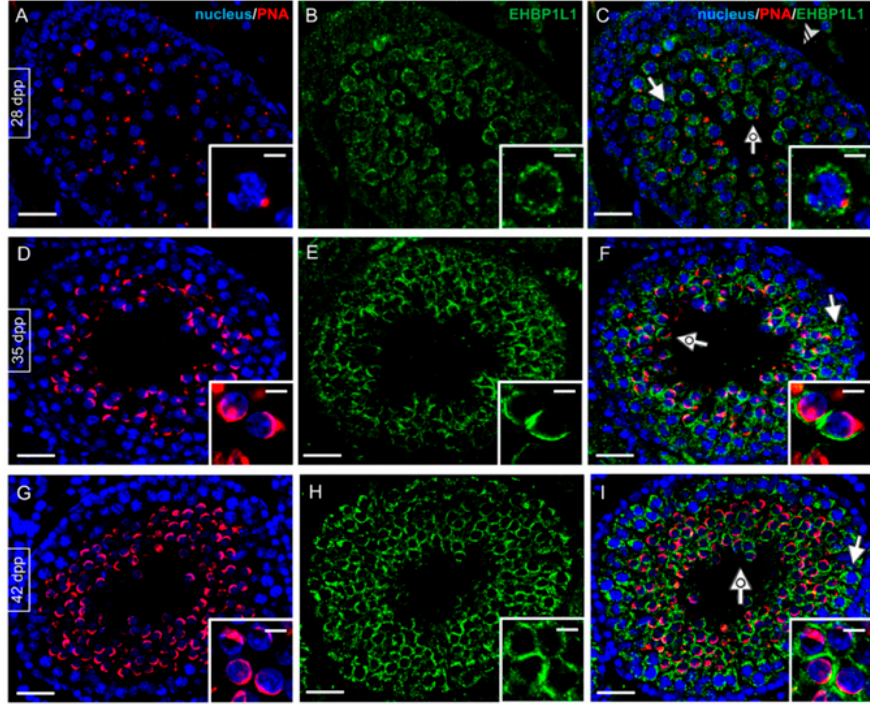
Figure 4 . Localization of EHBP1L1 during the first wave of rat spermatogenesis (28–42 dpp). ( A , D , G ) DAPI-fluorescent nuclear staining (blue) and PNA lectin acrosome staining (red). ( B , E , H ) EHBP1L1 fluorescence (green). ( C , F , I ) Merged fluorescent channels (blue/red/green). ( A – C ) 28 dpp testis; ( D – F ) 35 dpp; ( G – I ) 42 dpp. Scale bars represent 20 μ m, except for the insets, where they represent 10 μ m. Striped arrowhead: SPG; arrow: I SPC; dotted arrow: rSPT.